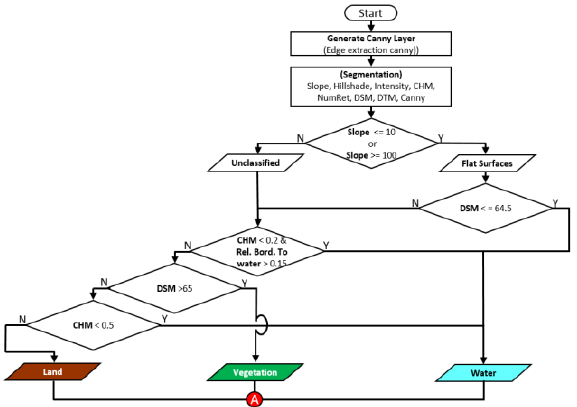
Figure 1a. Detailed workflow of Land, Vegetation and Water feature extraction.